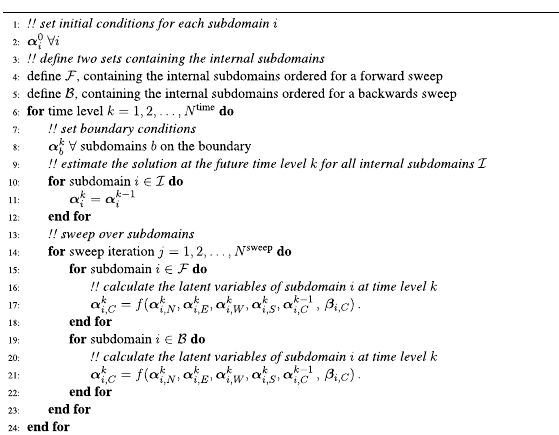
Algorithm 1. An algorithm for fi nding the solution for the reduced variables in a subdomain and sweeping over all the subdomains to obtain a converged solution over the whole domain. The algorithm marches forward in time from the initial condition to time level N time .